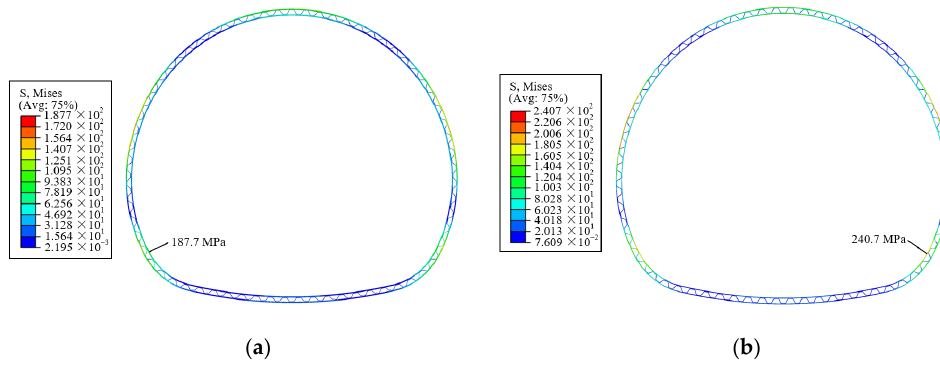
Figure 20. Stress nephogram of the SRS arch and grid arch (Unit: MPa). ( a ) SRS arch and ( b ) grid arch.